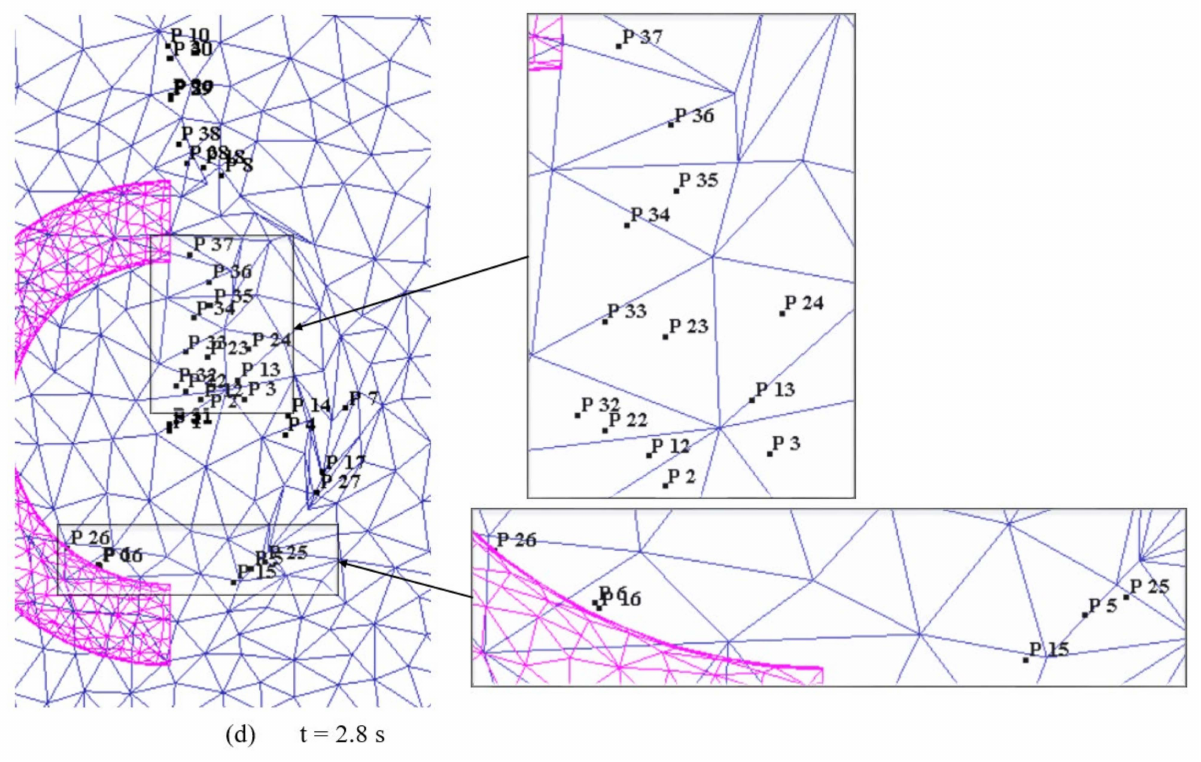
Figure 13. Point tracking positions representing material movement during refilling stage: ( a ) Front view − 2.1 s; ( b ) Front view − 2.8 s; ( c ) Top view − 2.1 s; ( d ) Top view − 2.8 s.